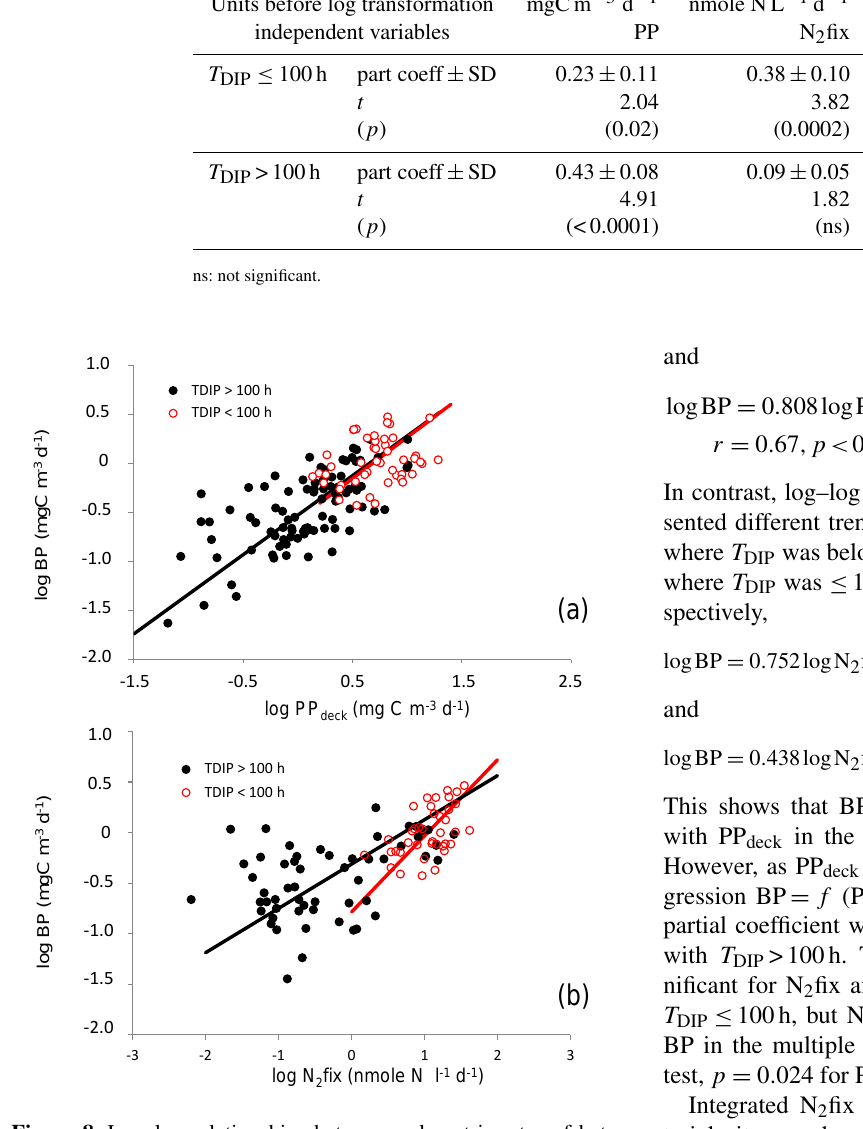
Figure 8. Log–log relationships between volumetric rates of het- erotrophic prokaryotic production (BP) and primary production (PP, a ) and between BP and nitrogen fixation rates (N 2 fix, b ). Red and black dots show samples where T DIP were < and > than 100h, re- spectively. Lines are fitted Tessier model II regressions for data clus- tering samples where T DIP values were greater (black lines) and lower (red lines) than